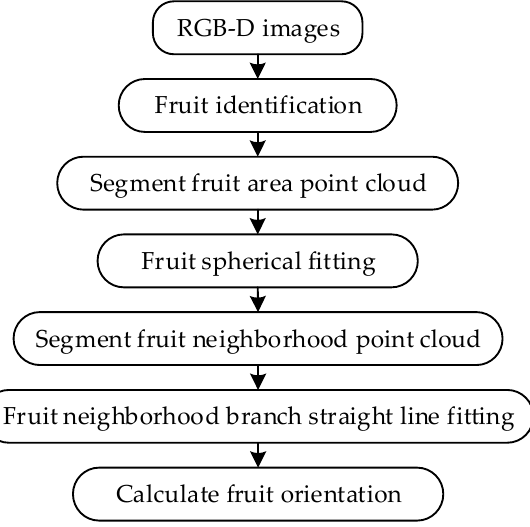
Figure 4. Flowchart of apple orientation determination algorithm.